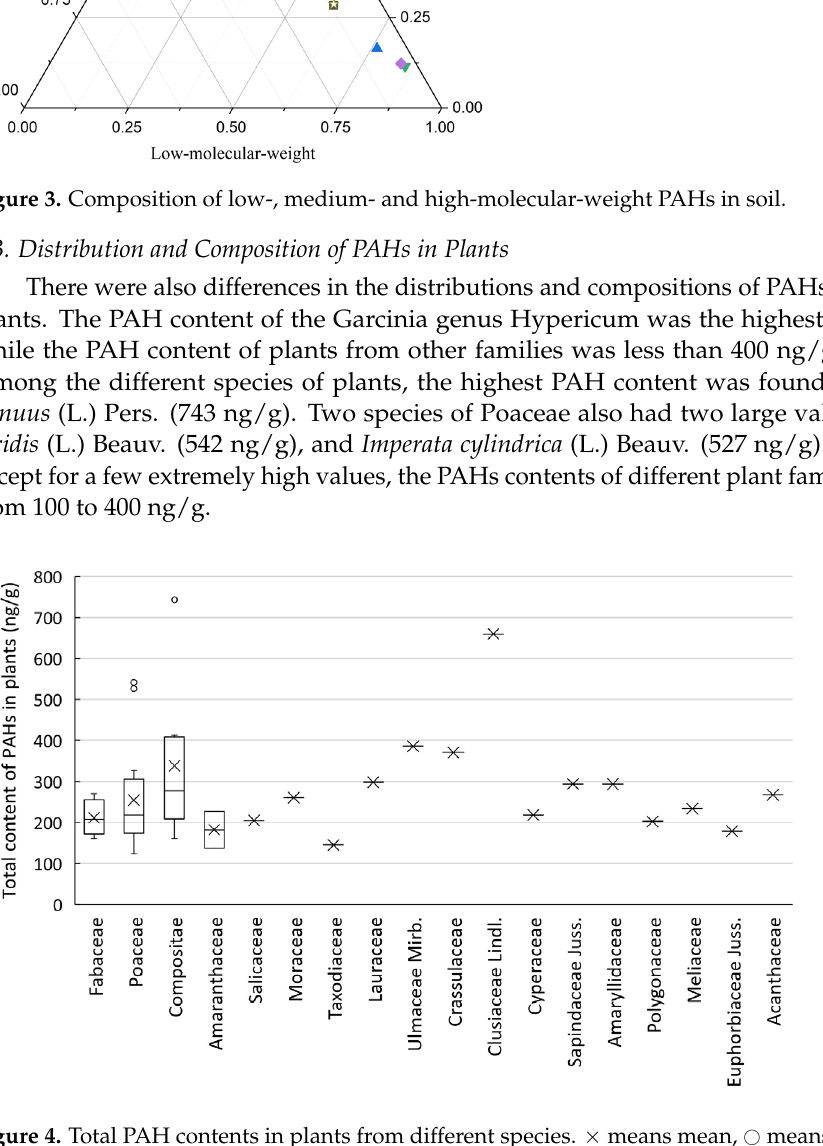
means outlier and - (cid:35)